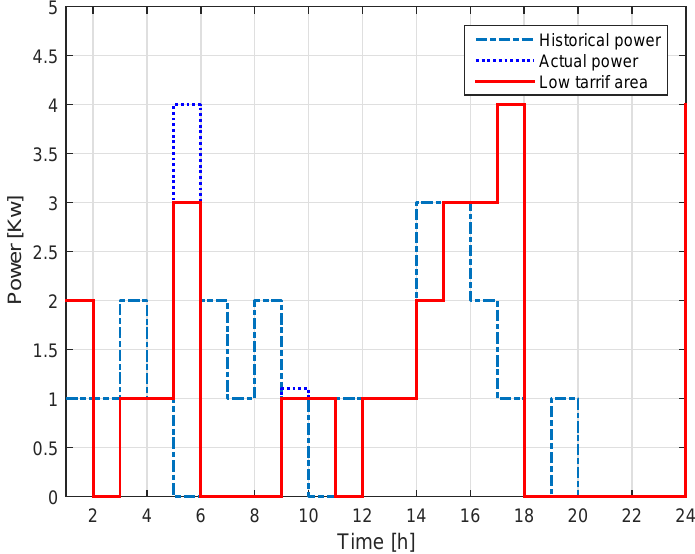
Figure 2. Historical power demand compared to power profile output by MILP solver for a single dwelling on a given